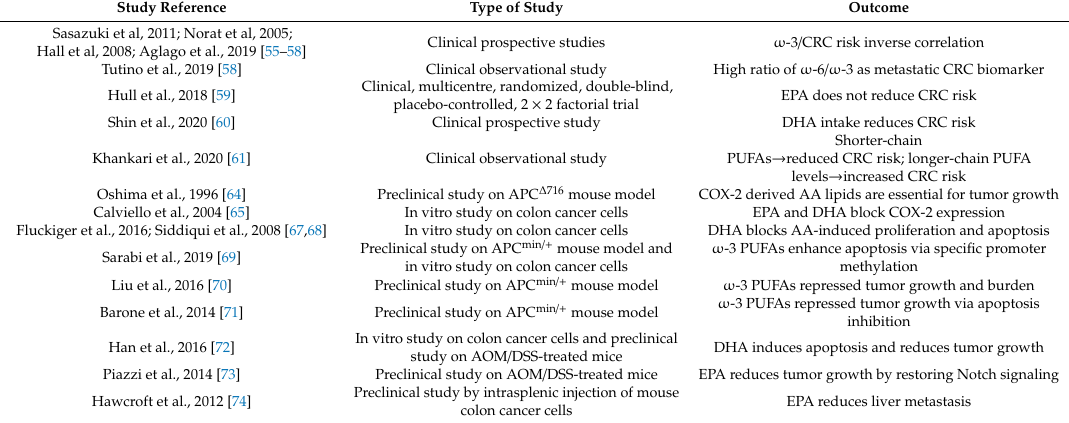
Table 1. A table listing the clinical and preclinical studies investigating the role of ω -3 polyunsaturated fatty acids (PUFAs) in